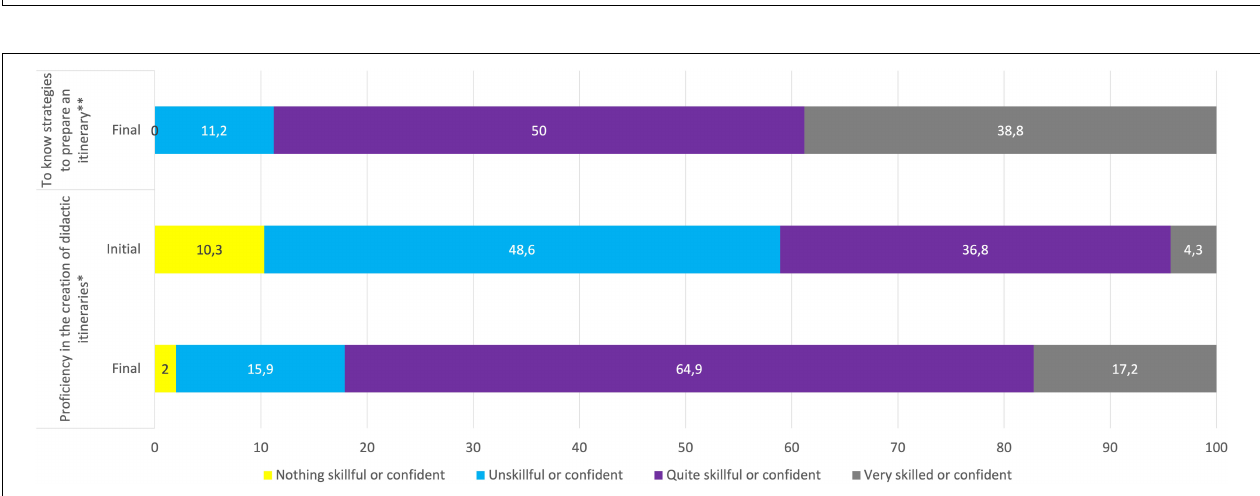
GRAPH 1 | Level of performance according to the indicators chosen from the assessment scale. Percentages.